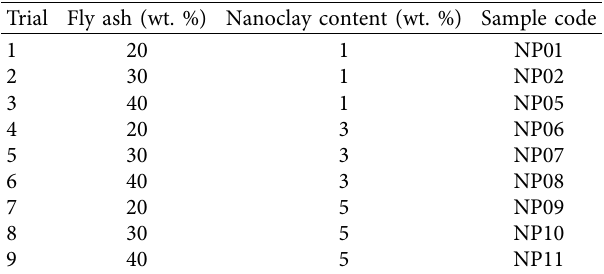
Table 1: Taguchi orthogonal array of designed experiments based on the coded